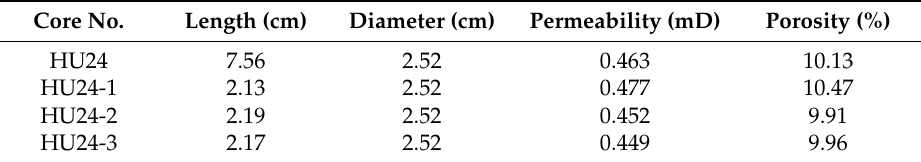
Table 3. Basic parameters of the core samples.